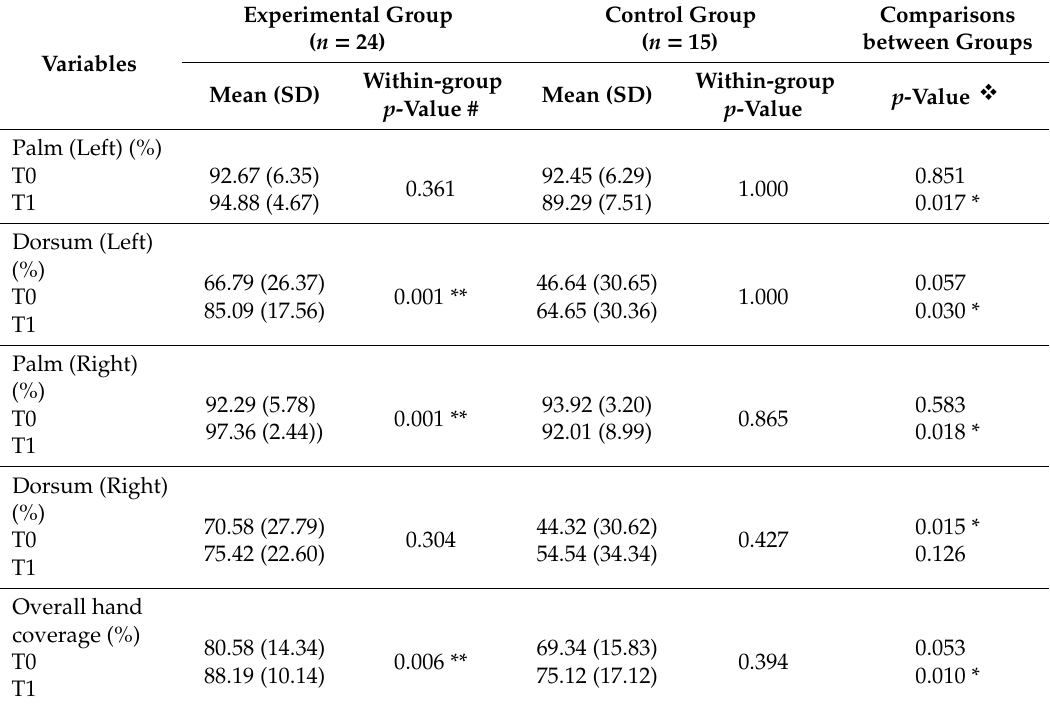
Table 2. Within-group and between-group comparisons of hand coverage (%) using hand sanitizer.